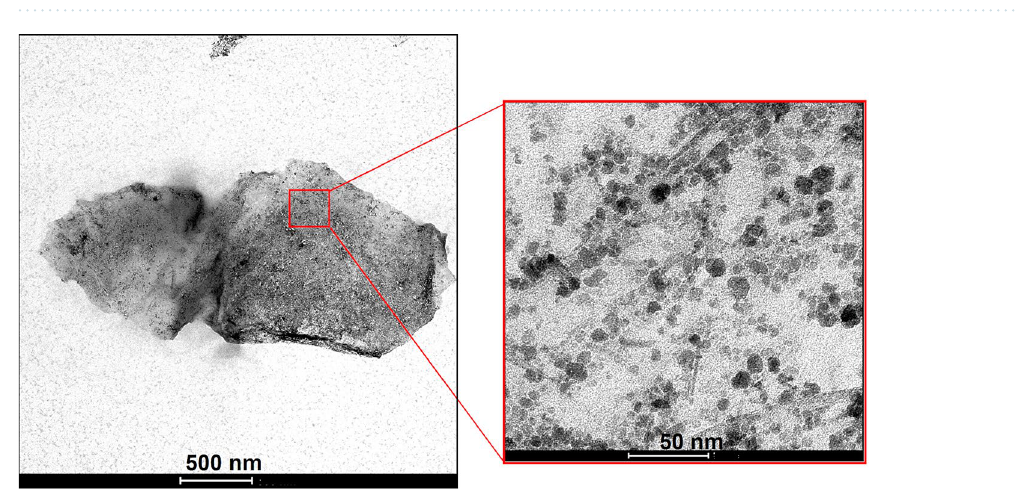
Figure 6. TEM images of Ch-rGO/Fe 3 O 4